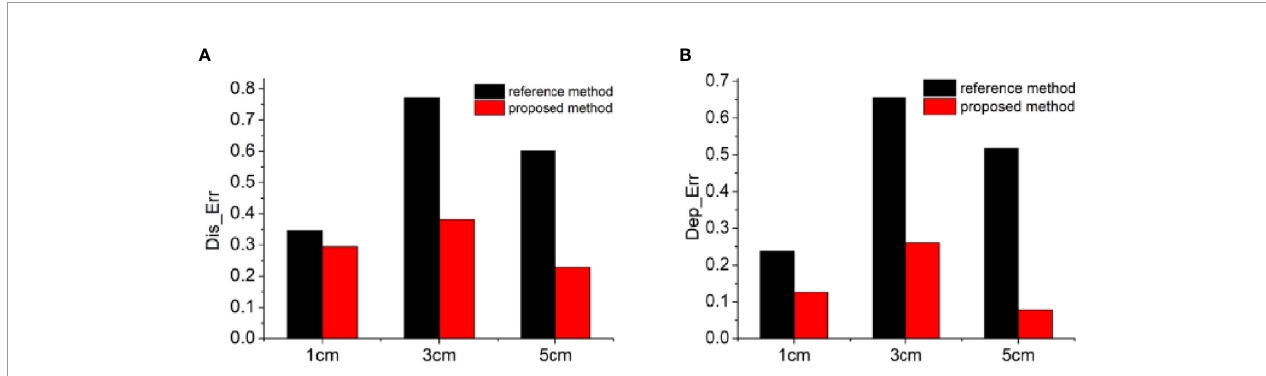
FIGURE 3 | Quantitative analysis of the reconstruction results. The calculated values of the indicators of Dis_err (A) and Dep_err (B) . The black bars show the distance or depth errors of the reconstructed results by the reference method, and the red bars represent those obtained by the proposed